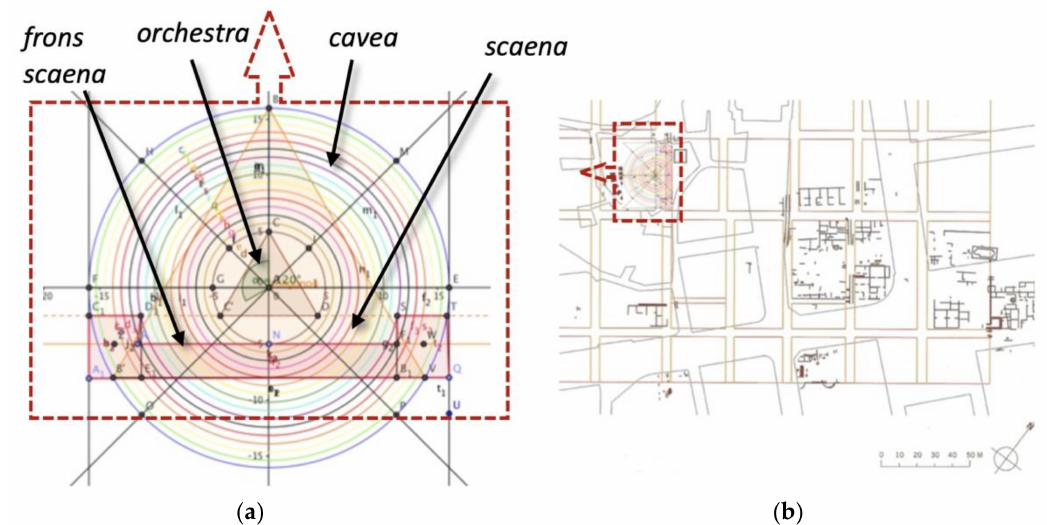
Figure 4. ( a ). Drawing of the theater model built by Group 8 using GeoGebra; ( b ). Model simulation proposed by Group 8 superimposing it onto the archaeological site